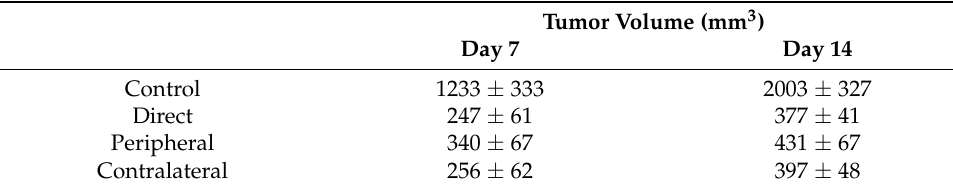
Figure 6. Antitumor effect of lenvatinib sheets in the different insertion positions. The mice were categorized into four groups according to the treatment method: the control (open circle; day 0: n = 11, day 7: n = 6, and day 14: n = 11), direct (filled triangle; day 0: n = 10, day 7: n = 5, and day 14: n = 10), peripheral (open diamond shape; day 0: n = 10, day 7: n = 5, and day 14: n = 10), and contralateral (filled square; day 0: n = 10, day 7: n = 5, and day 14: n = 10) groups. ( A ) Schematic diagram of the mice. ( B ) Time course of xenograft tumor volume. ( C ) Trends of serum lenvatinib level. ( D ) Body weight in each group. Data are presented as means ± standard deviations. ** p < 0.01 compared with the control group. The results are the sum of two independent experiments. Table 4. Tumor volume in different insertion positions.